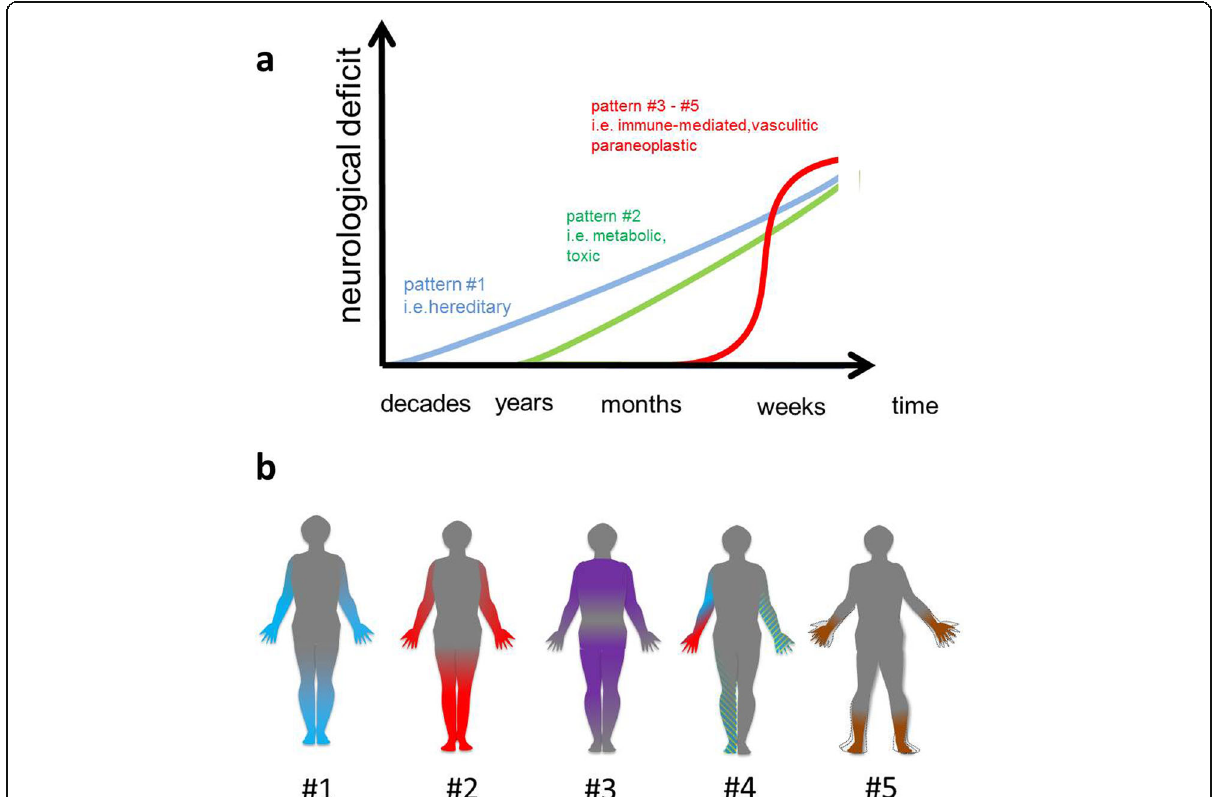
Fig. 2 a Disease onset and temporal evolution characteristics of distinguishable clinical patterns and different causes of peripheral neuropathy. b Clinical patterns of polyneuropathy: Sensory deficits are drawn in blue, motor deficits are drawn in red, and sensorimotor in magenta color. Painful and / or autonomous dysfunction is colored with green lines. Loss of proprioception is colored in brown. Pattern #1 is a distal symmetric predominantly sensory neuropathy, #2 a motor neuropathy with muscle wasting and foot abnormalities; pattern #3 is characterized by proximal involvement of sensory and motor nerve fibers, pattern #4 presents wih multifocal symptoms, neuropathic pain, and autonomic dysfunction. Pattern #5: is a sensory ataxic